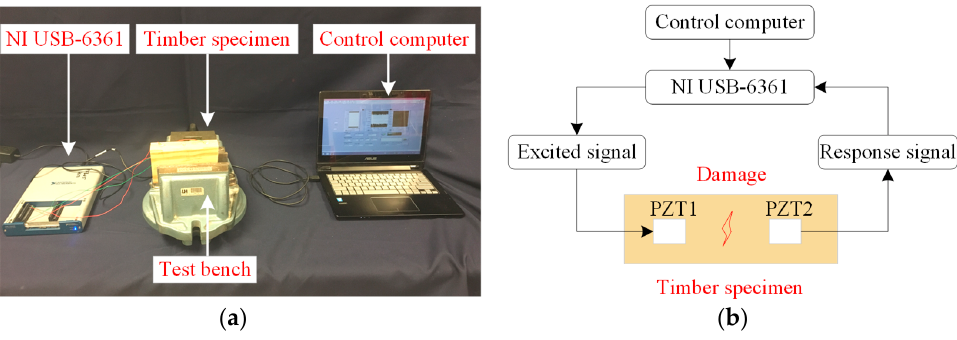
Figure 5. ( a ) A photo of the apparatus, ( b ) The schematic diagram of the apparatus.